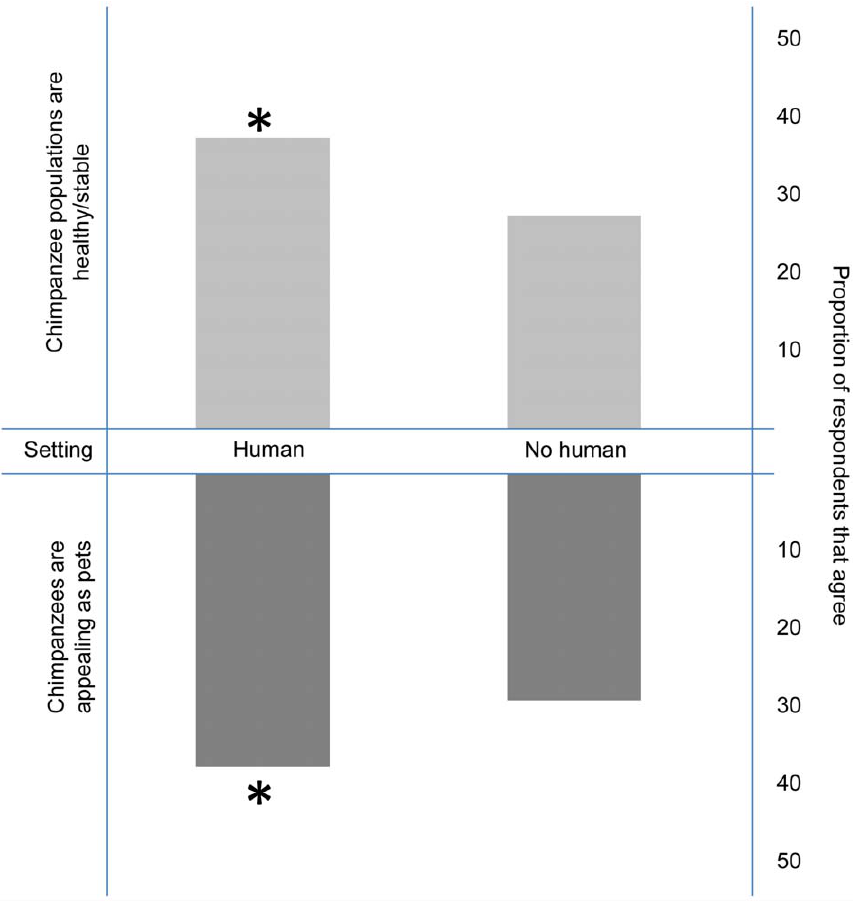
Figure 2. Effect of human presence on perception of chimpanzee population status and appeal as pets. Detailed legend: The top bars display the proportion of survey respondents that agreed that wild chimpanzee populations were healthy/stable when viewing one of two versions of a composite image. In one version of the image, an adult human male was shown standing adjacent to the chimpanzee. In the second version, the chimpanzee was shown without any human present. The bottom bars display the proportion of survey respondents that agreed that chimpanzees were appealing as pets after viewing one of the same images with humans present or not present.